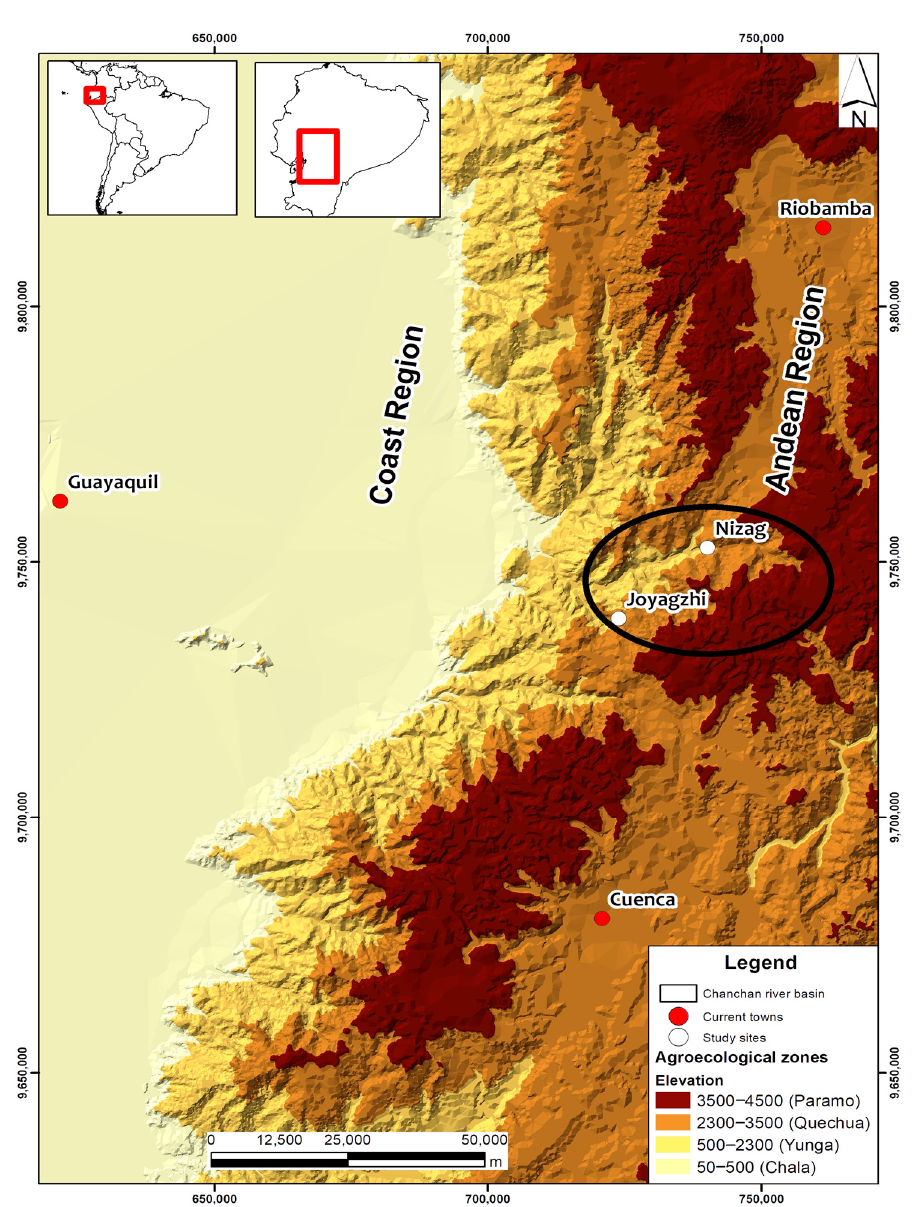
Figure 3. The geographical location of the archeological landscape of the Chanchán basin, concern- ing the Joyagzhí archeological terraces and the Nizag community (Andes of Ecuador).